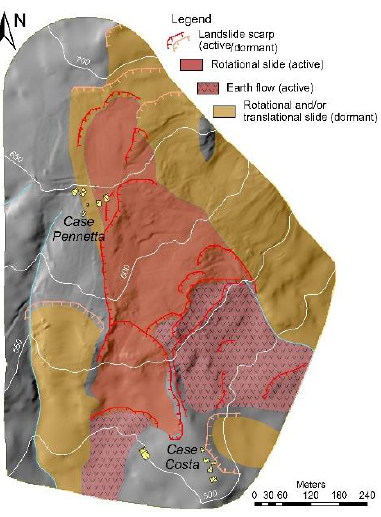
Figure 2. Geomorphological map. The contour lines show the altitude in meters above sea